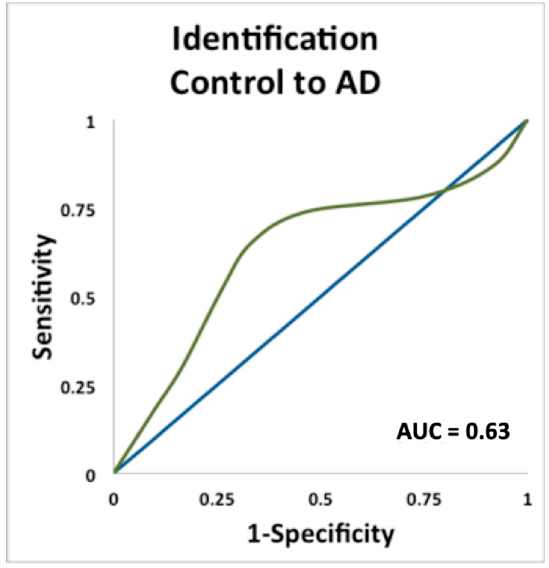
Figure 2. ROC curve plotting sensitivity and specificity for predicting conversion from cognitively normal controls to AD, using odor identification.